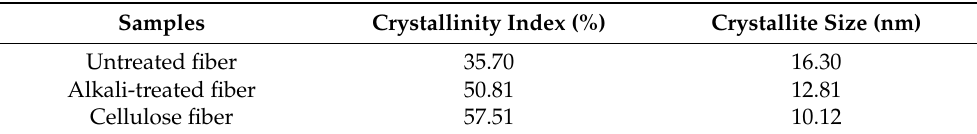
Table 3. Crystallinity index and crystallite sizes of untreated, alkali-treated and cellulose fibers.